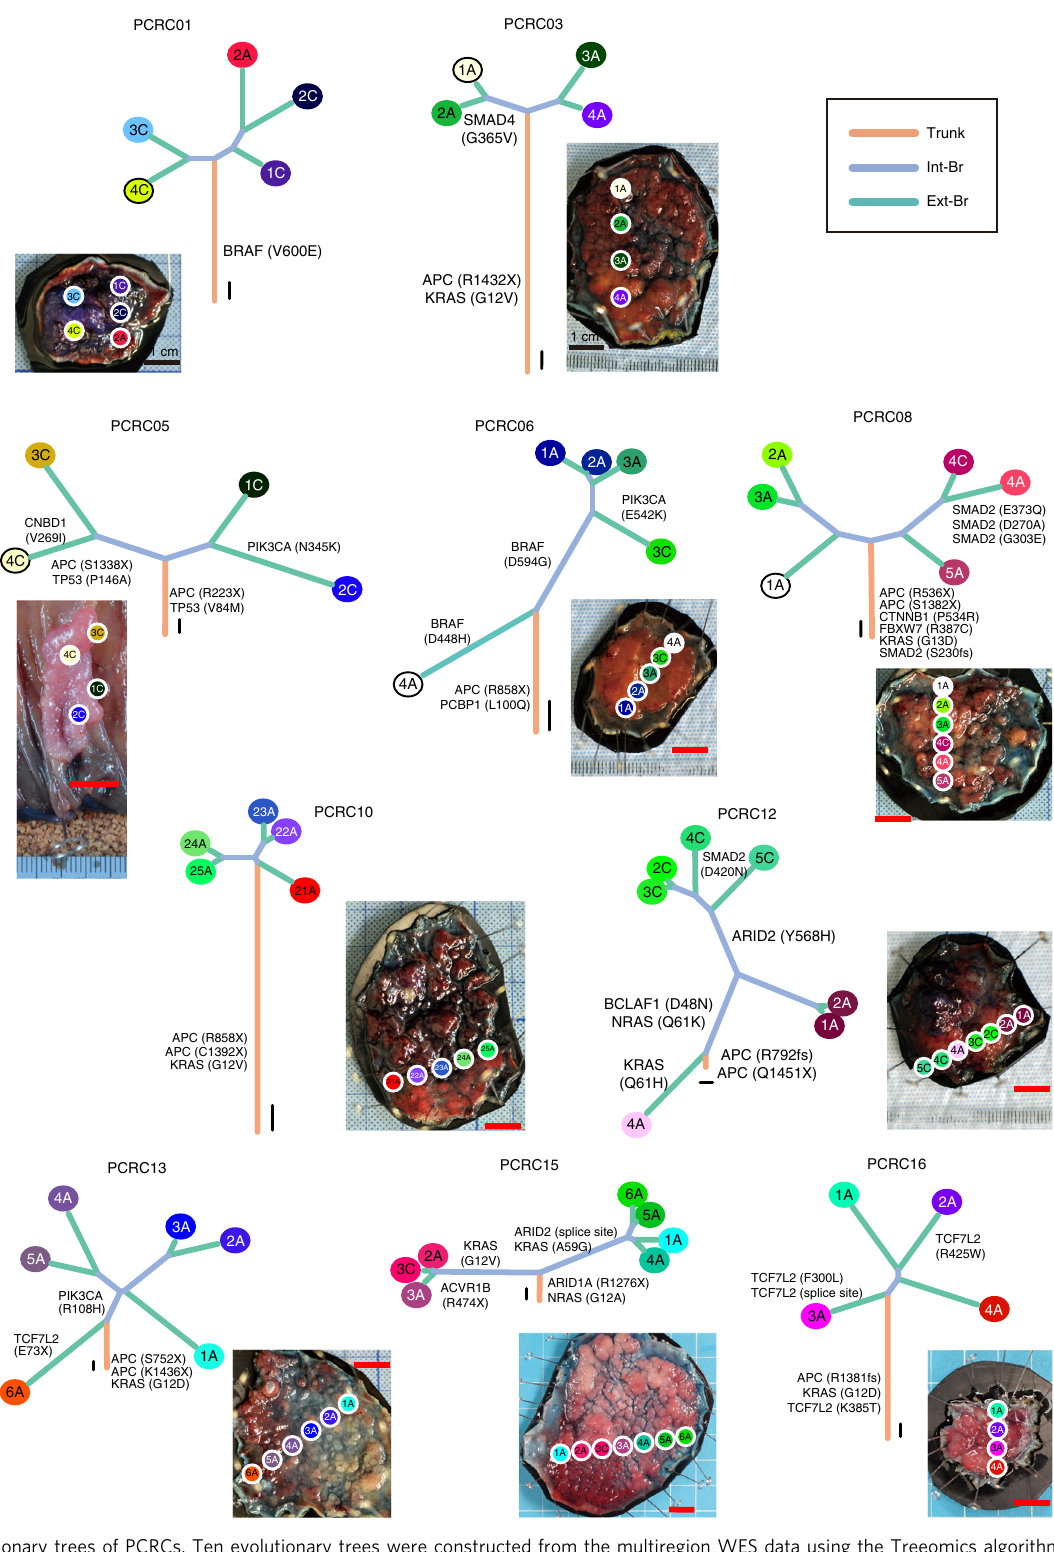
Fig. 2 Evolutionary trees of PCRCs. Ten evolutionary trees were constructed from the multiregion WES data using the Treeomics algorithm. Trunks, internal branches (int-Br), and external branches (ext-Br) generally correspond to ubiquitous, shared, and private mutations, respectively, while leaves correspond to samples. The colors of the leaves are the same as the sample labels in Fig. 1. Lengths of the trunk and branches represent the number of mutations, and scales for ten mutations are shown near the roots of the evolutionary trees. Driver genes with possible functional mutations are mapped along the evolutionary trees. The photo of each tumor is provided with positions from which each sample was obtained. Red scale bars for one centimeter attempted with each